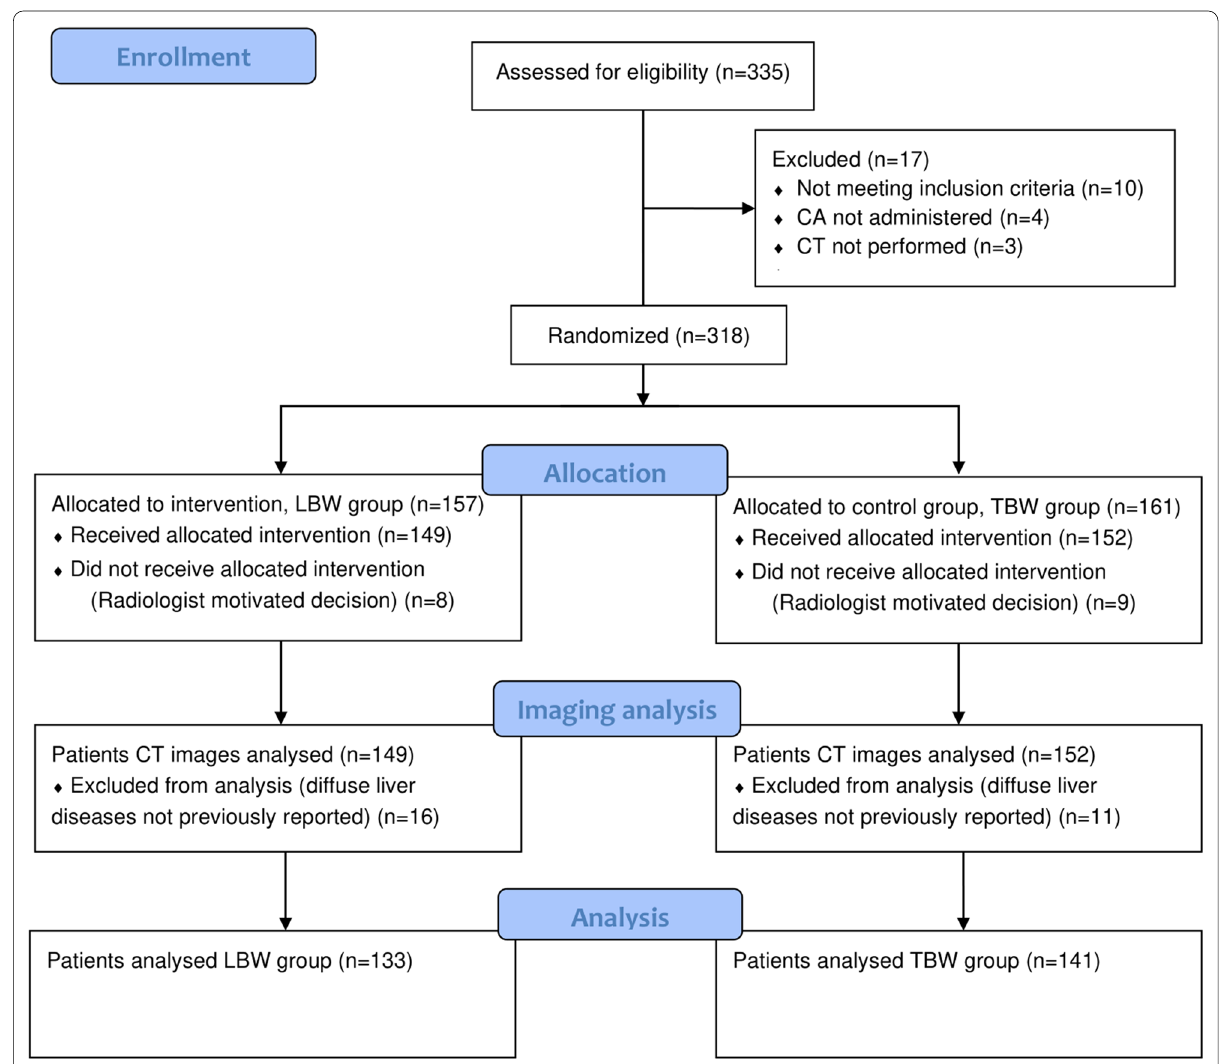
Fig. 1 Flow diagram of the progress through the phases of two groups (enrolment, allocation, imaging analysis, and data